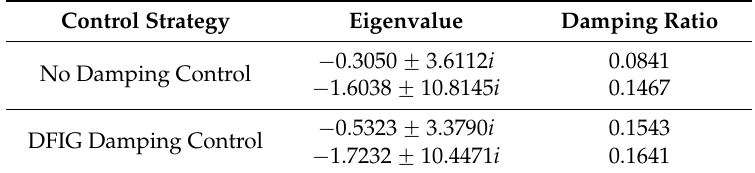
Table 2. Electromechanical modes of wscc system with and without dfig damping control.